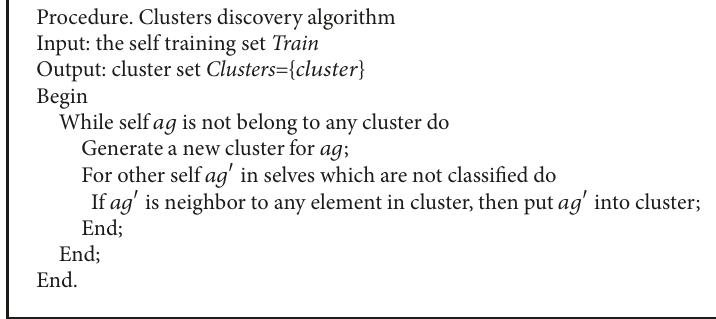
Algorithm 5: The process of clusters discovery algorithm.